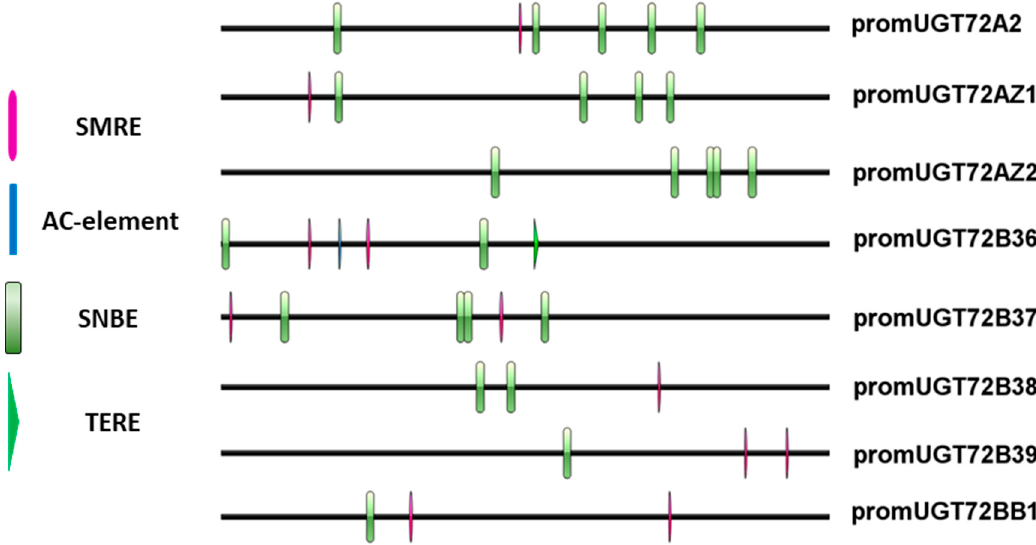
Figure 7. Secondary cell wall-related cis-elements in the promoters of poplar UGT72 members. SMRE, Secondary wall MYB-Responsive Element. SNBE, Secondary wall NAC-Binding Element. AC-element, R2R3MYB Responsive Element. TERE, Tracheary-Element-Regulating cis -Element. The cis -element sequences and the associated binding factors in Arabidopsis are listed in Table S4. The analysis was made on the 1500 bp upstream the coding sequences.